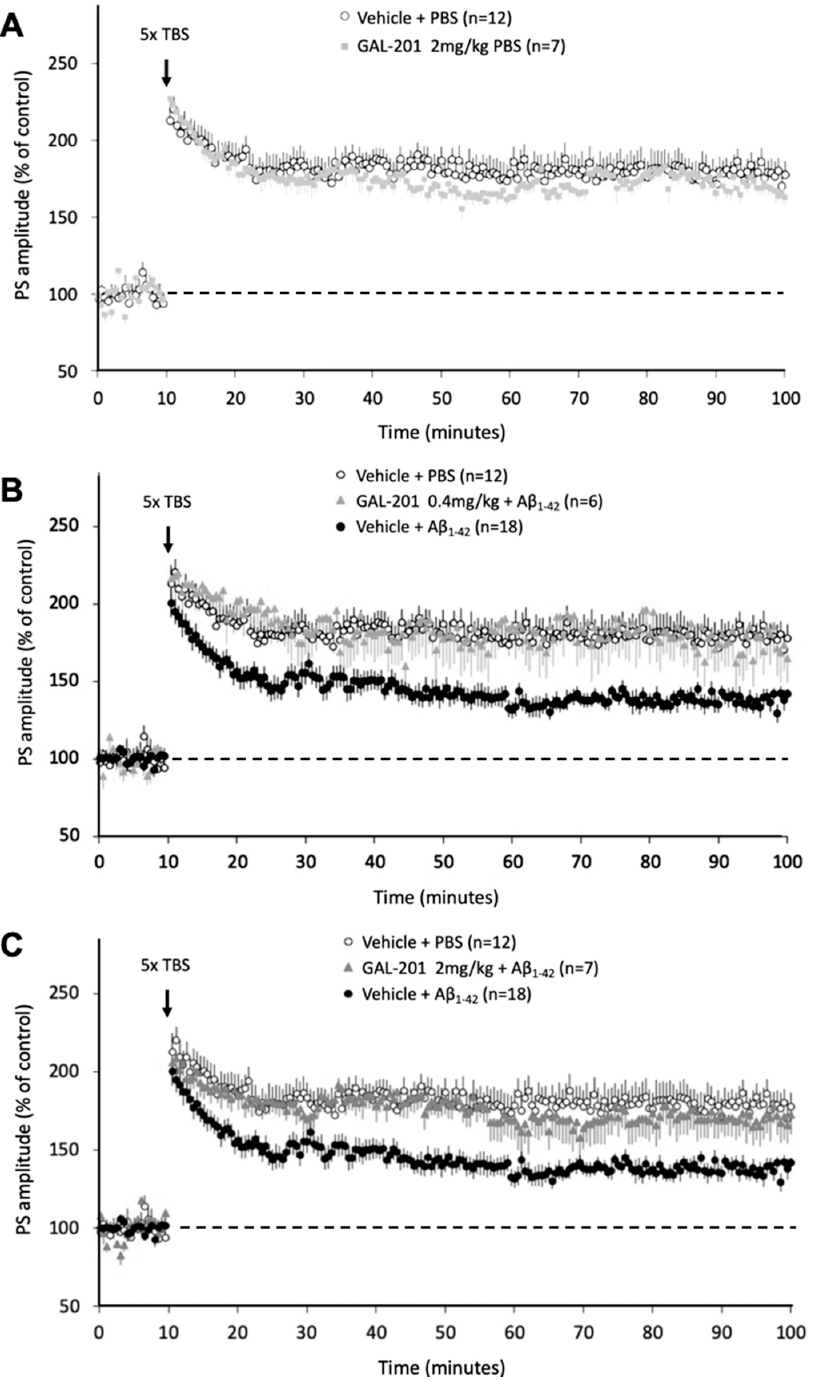
Figure 9. In vivo LTP in rats with i.c.v. applied A β 1-42 and subcutaneously applied GAL-201. ( A ) Preliminary studies tested the effects of a 2 mg/kg dose of s.c. administered GAL-201 on TBS-induced hippocampal LTP, in the absence of oligomeric A β 1-42 . GAL-201 2 mg/kg itself did not confer any significant inhibitory or facilitatory effect on hippocampal synaptic responses following theta burst stimulation. ( B ) In animals subjected to i.c.v injection of 6 µL oligomeric A β 1-42 preceded by s.c. vehicle, significant deficits in LTP were observed. In animals subjected to i.c.v injection of 6 µL oligomeric A β 1-42 , a preadministration of s.c. GAL-201 2 mg/kg protected against oligomeric A β 1-42 -induced deficits in hippocampal LTP. ( C ) In animals subjected to i.c.v injection of 6 µL oligomeric A β 1-42 , a preadministration of s.c. GAL-201 0.4 mg/kg demonstrated a protection against oligomeric A β 1-42 -induced deficits in hippocampal